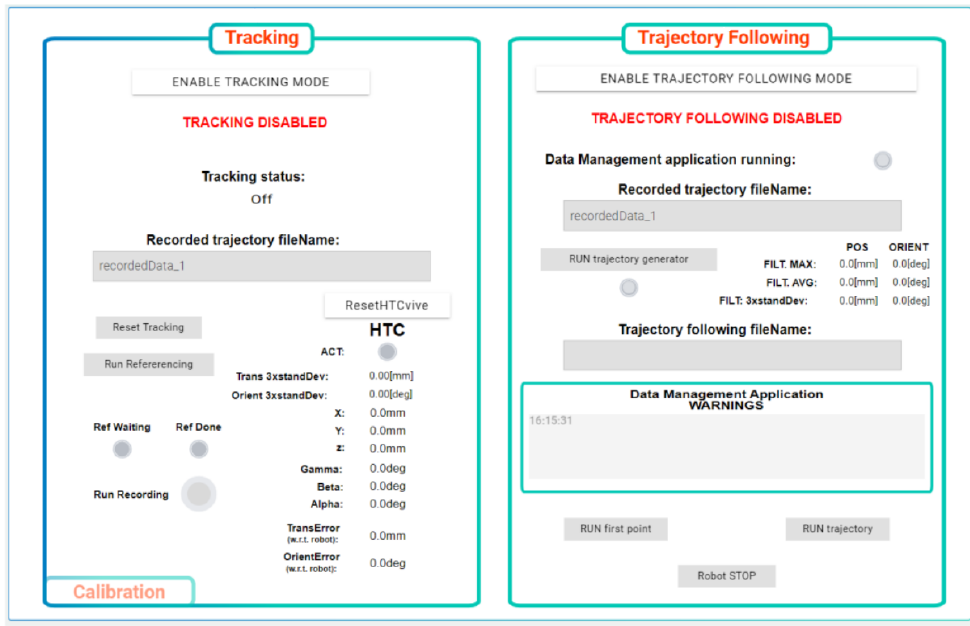
Figure 8. Human machine interface—high-level part for tracking system and trajectory following.